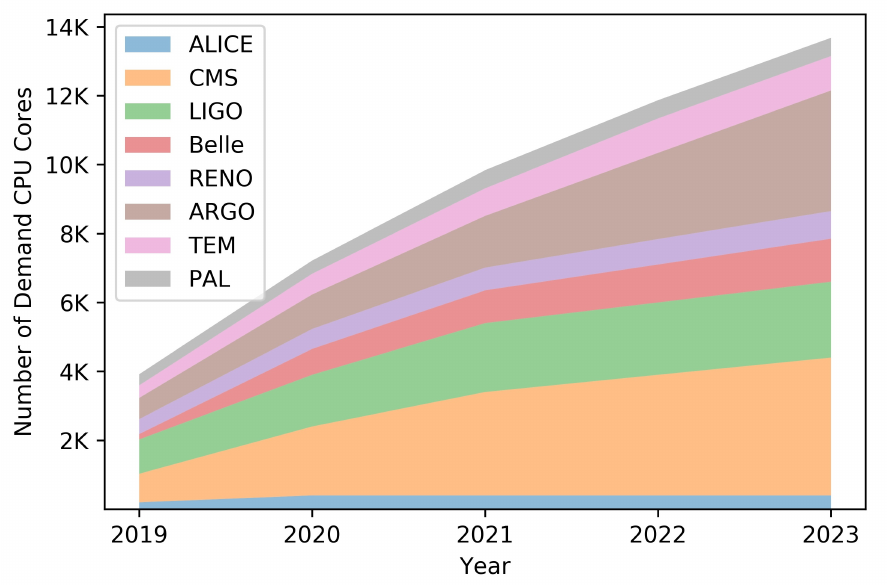
Figure 1. Results of resource demand survey requested by a group of Korean